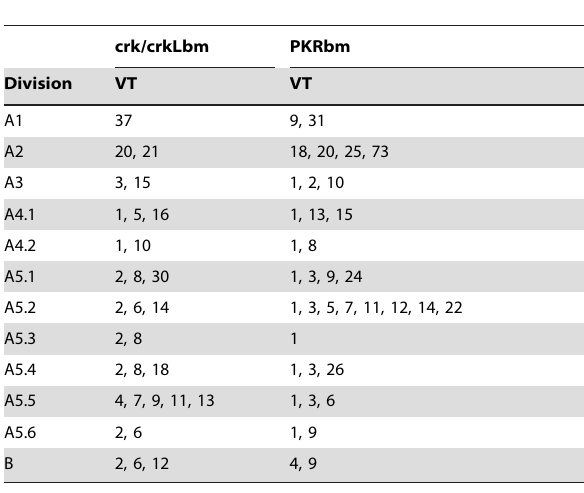
Table 6. Distinct functional sequence feature variant types (SF-VT) [42] are characteristic of each NS1 class obtained by RNA phylogenetic